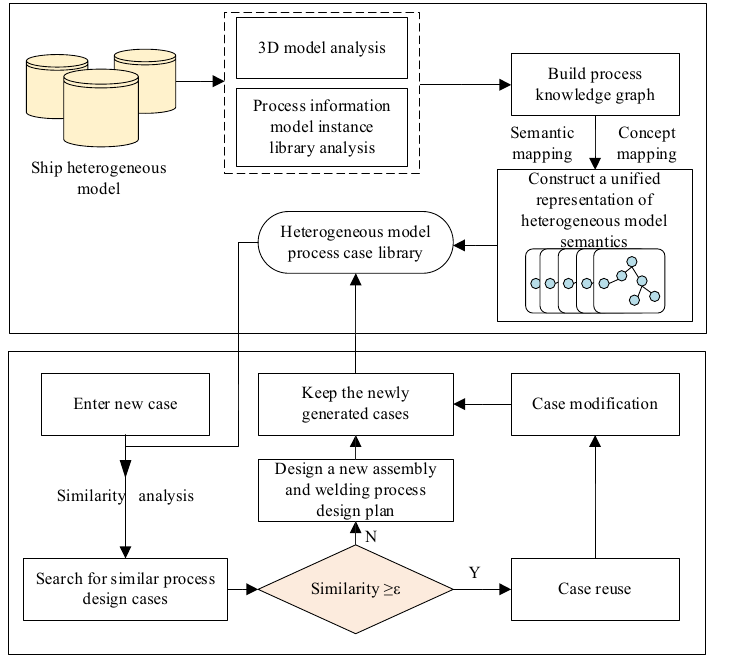
Figure 1. A general flow chart of the method presented in this